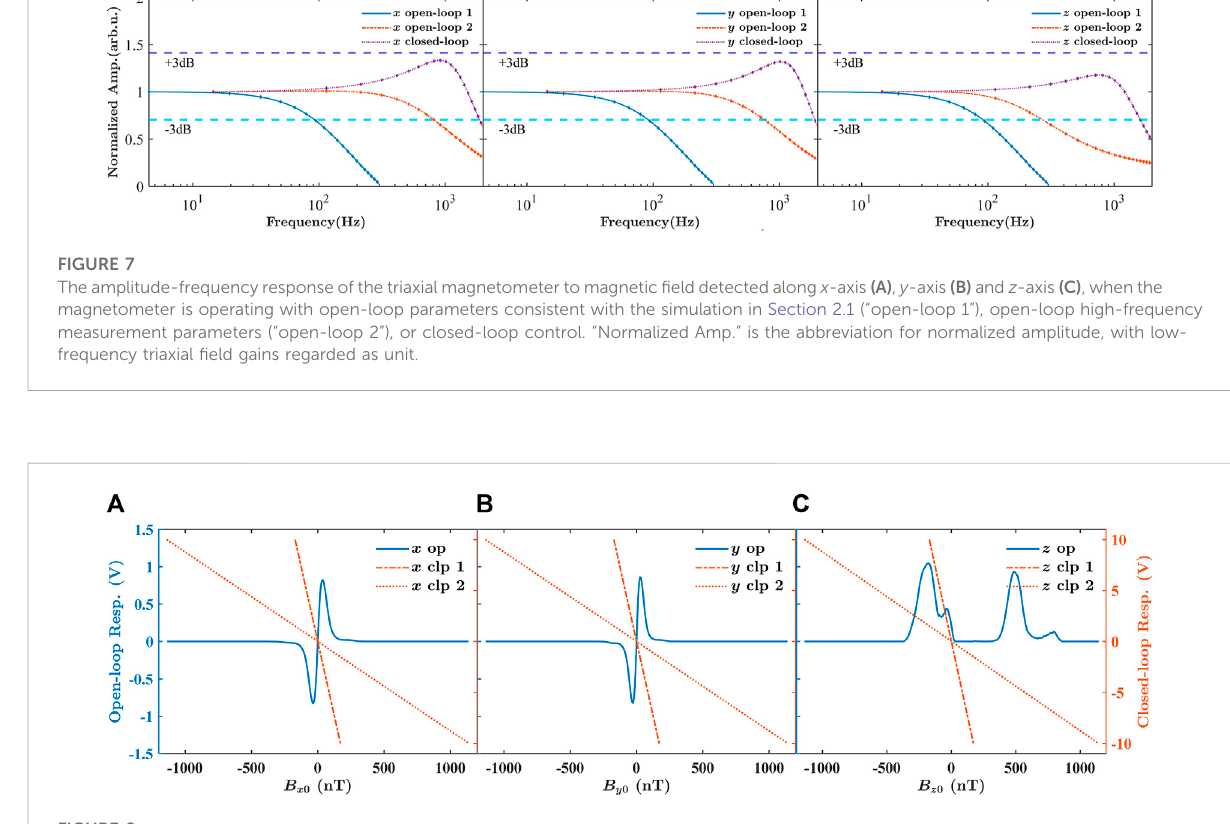
FIGURE 8 Responses of the triaxial magnetometer to magnetic fi eld offset sweep, when the magnetometer is operating in open-loop mode ( “ op ” ), when the magnetometer is operating in closed-loop mode without changing coil constants ( “ clp 1 ” ), and when the magnetometer is operating in closed- loopmodewithincreasedcoilconstants( “ clp2 ” ). (A) Thesweepisalong x -axis. (B) Thesweepisalong y -axis. (C) Thesweepisalong z -axis. “ Resp. ” is the abbreviation for response. The open-loop dynamic range of the three axes: 18 nT along x axis; 13 nT along y axis; 35 nT along z axis.